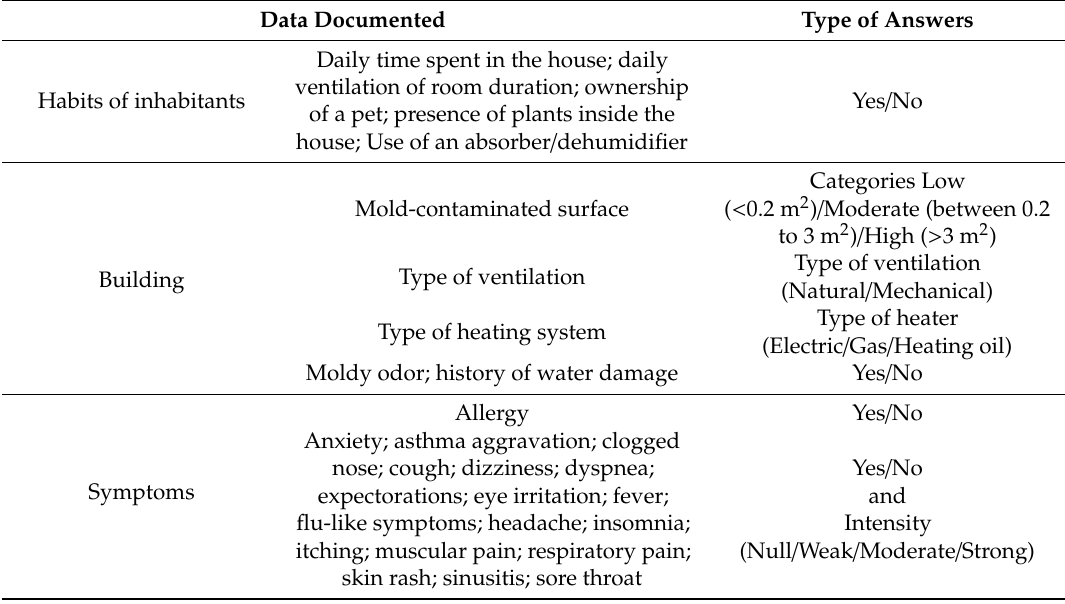
Table 1. Main parameters documented in the questionnaire completed during home